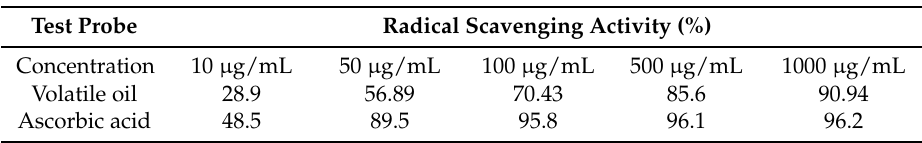
Table 3. DPPH radical scavenging activity of volatile oil of G. pfeifferi